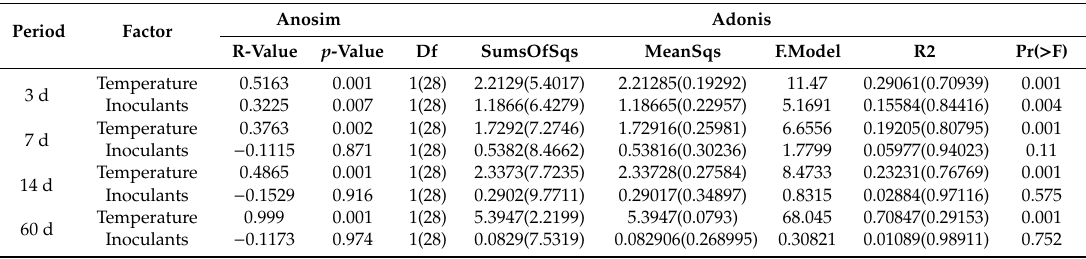
Table 3. Statistical analysis for the operational taxonomic units (OTUs) of corn silages treated with temperature and inoculants at di ff erent fermentation